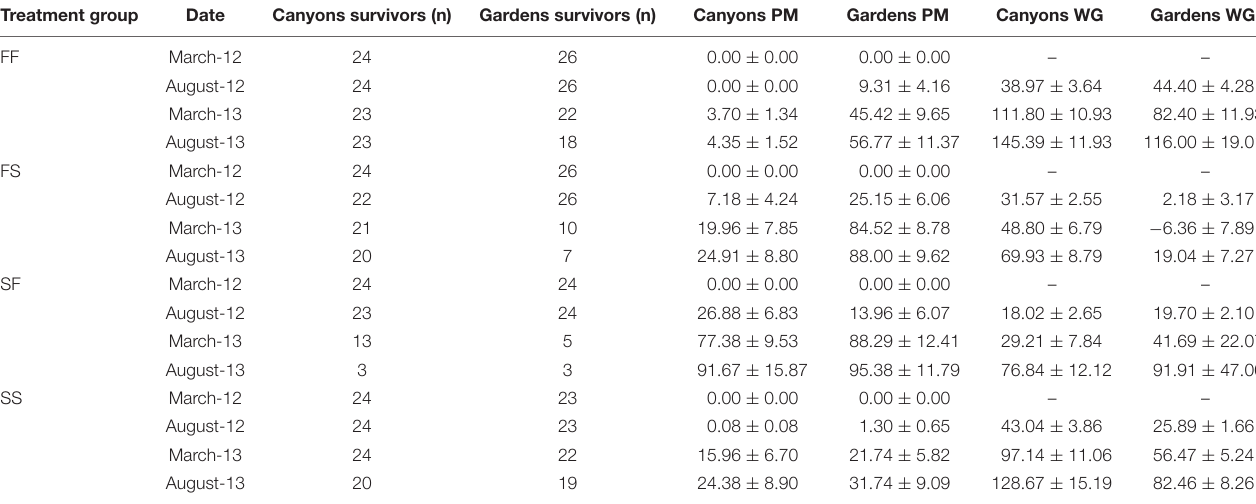
TABLE 1 | The number of survivors (n), average partial mortality (PM) ± SE, and average cumulative weight gain (WG) ± SE per site and treatment group at each sampling time point. Treatment